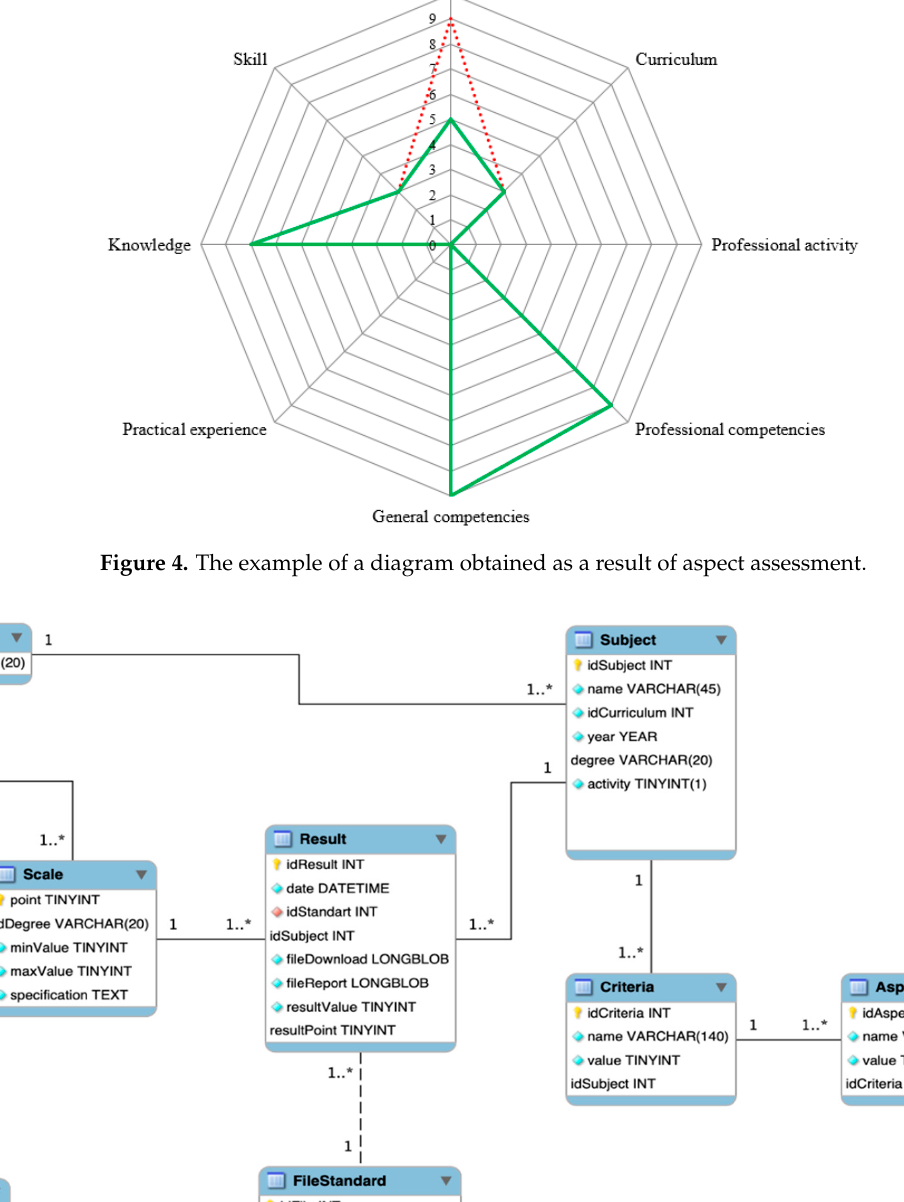
Figure 5. Entity–relationship (ER) model of data from the database of the information system for monitoring the quality of educational programs.